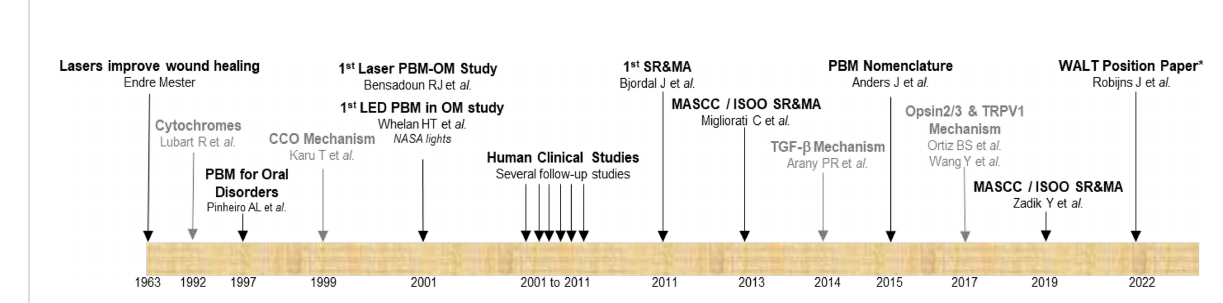
FIGURE 1 Timeline of advances in the application of PBM therapy for oral mucositis. The grey font represents basic science advances. *current WALT position paper. Abbreviations used SR&MA – Systematic review and meta-analysis; OM – Oral Mucositis; PBM - Photobiomodulation; MASCC – Multinational Association for Supportive Care in Cancer; ISOO – International Society for Oral oncology; WALT – World Association for Photobiomodulation Therapy; CCO – Cytochrome C Oxidase; TGF- b – Transforming Growth Factor beta 1; TRPV1 - Transient Receptor Potential-V1